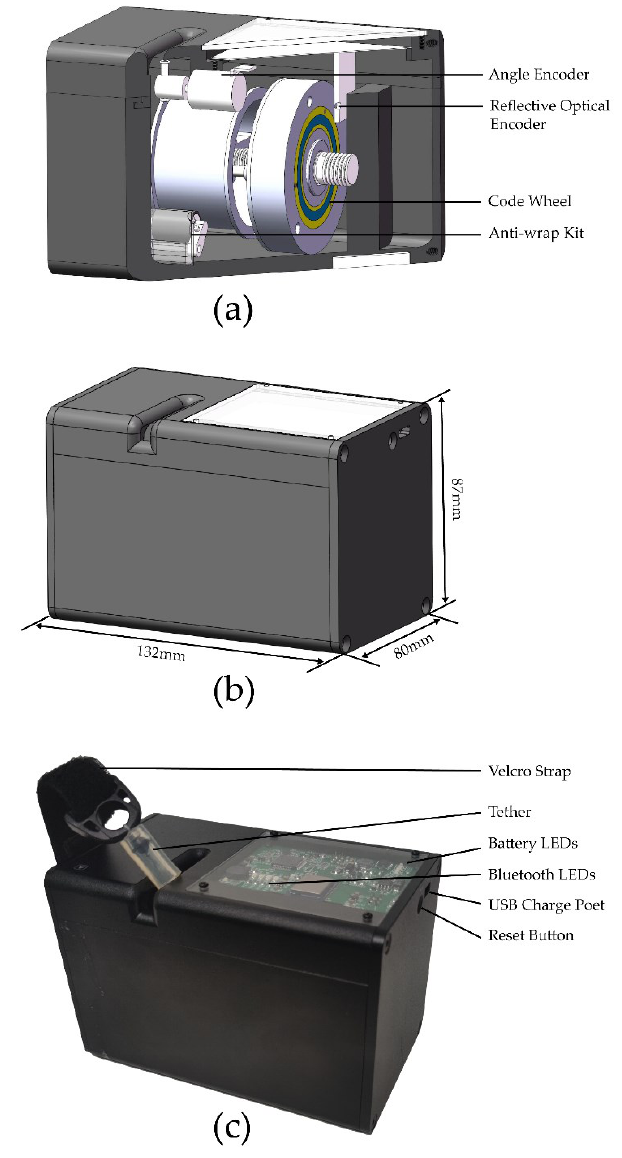
Figure 2. Data acquisition device overview: ( a ) 3D CAD model and components; ( b ) assembly drawing; ( c ) physical prototype.